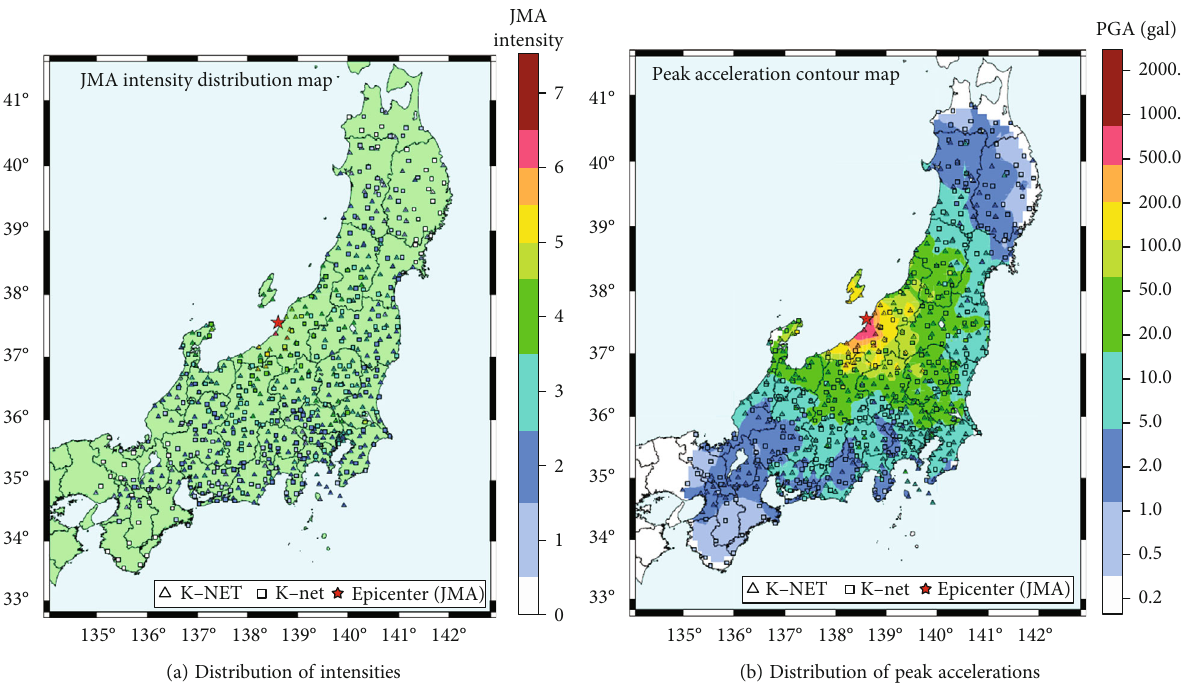
Figure 5: Distributions of intensities and peak accelerations recorded at the observation site of Ojiya City during the M6.8 Chuetsu o ff shore earthquake happened on July 16, 2007, in Niigata Prefecture,